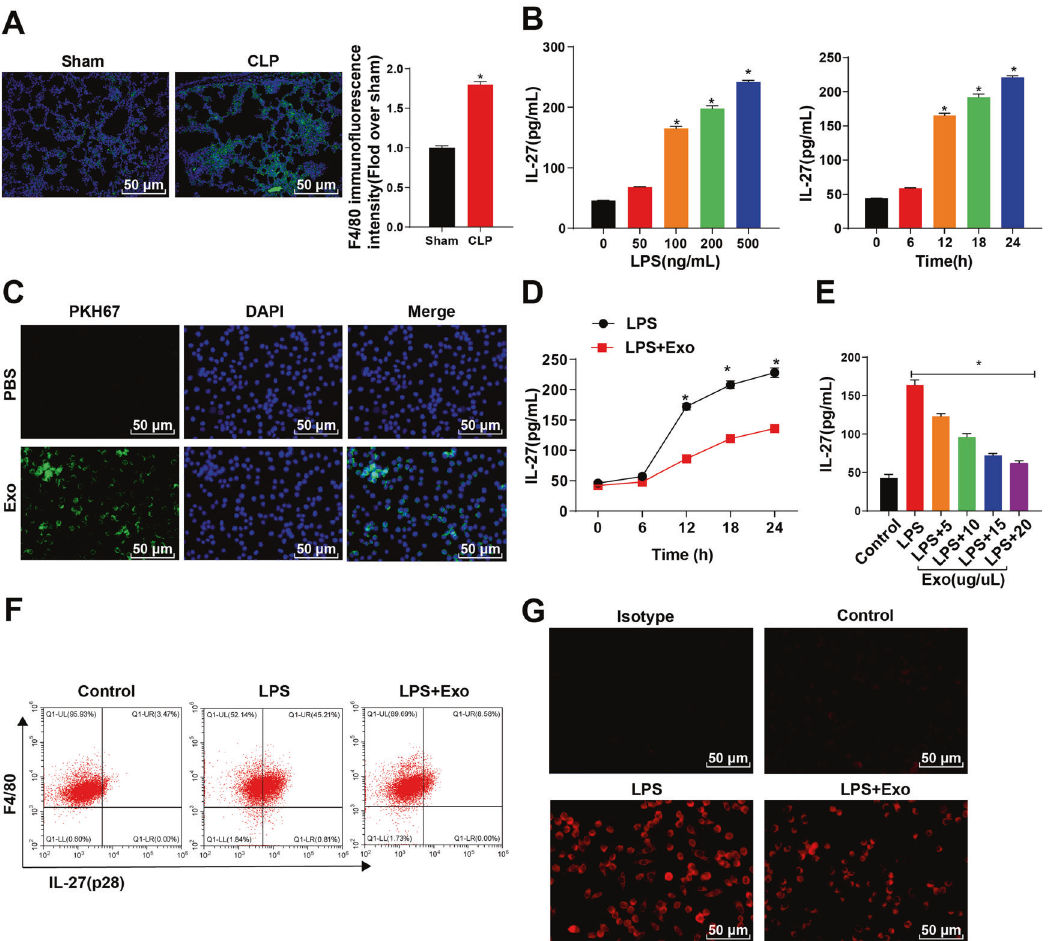
Fig. 3 ADMSC-exosomes inhibited the LPS-mediated release of IL-27 in macrophages. A F4/80 + macrophages in lung tissue were detected using immuno fl uorescence (green staining) (nuclei were labeled by DAPI and presented blue staining). B The level of IL-27 in the supernatant of BMDMs treated with different concentrations of LPS for 12 h or LPS (100 ng/mL) for different times was detected using ELISA. C PKH67 (green)-labeled ADMSC-exosomes were co-cultured with BMDMs for 24 h, and then the fl uorescence intensity of PKH67 in BMDMs was observed (DAPI-labeled nuclei were blue). D The time process of IL-27 release from BMDMs was detected using ELISA after the incubation of LPS (100 ng/mL) and ADMSC-exosomes (10 μ g/ μ L). E The dose response of ADMSC-exosomes at different concentrations to IL-27 released by LPS-activated BMDMs within 12 h was detected using ELISA; Control indicated that the BMDMs were at rest. F BMDMs after LPS incubation were detected, with the addition of ADMSC-exosomes for 12 h or not. G The red staining of IL-27 in BMDMs was detected after 12 h- incubation, and Isotype represented the negative control. The cell experiment was repeated 3 times independently. Measurement data are depicted as mean ± SD. One-way ANOVA was employed for the comparisons among multiple groups, followed by Tukey ’ s multiple comparisons test. * p <